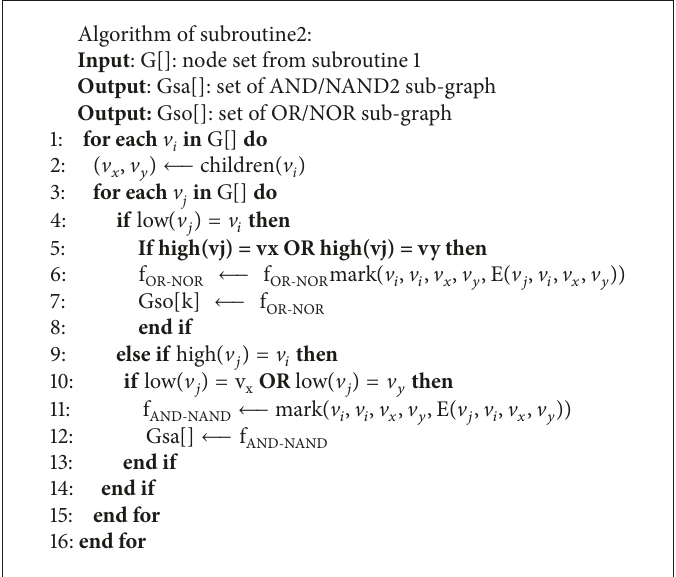
Algorithm 2: The algorithm of subroutine 2 in the BDD-based extraction algorithm.